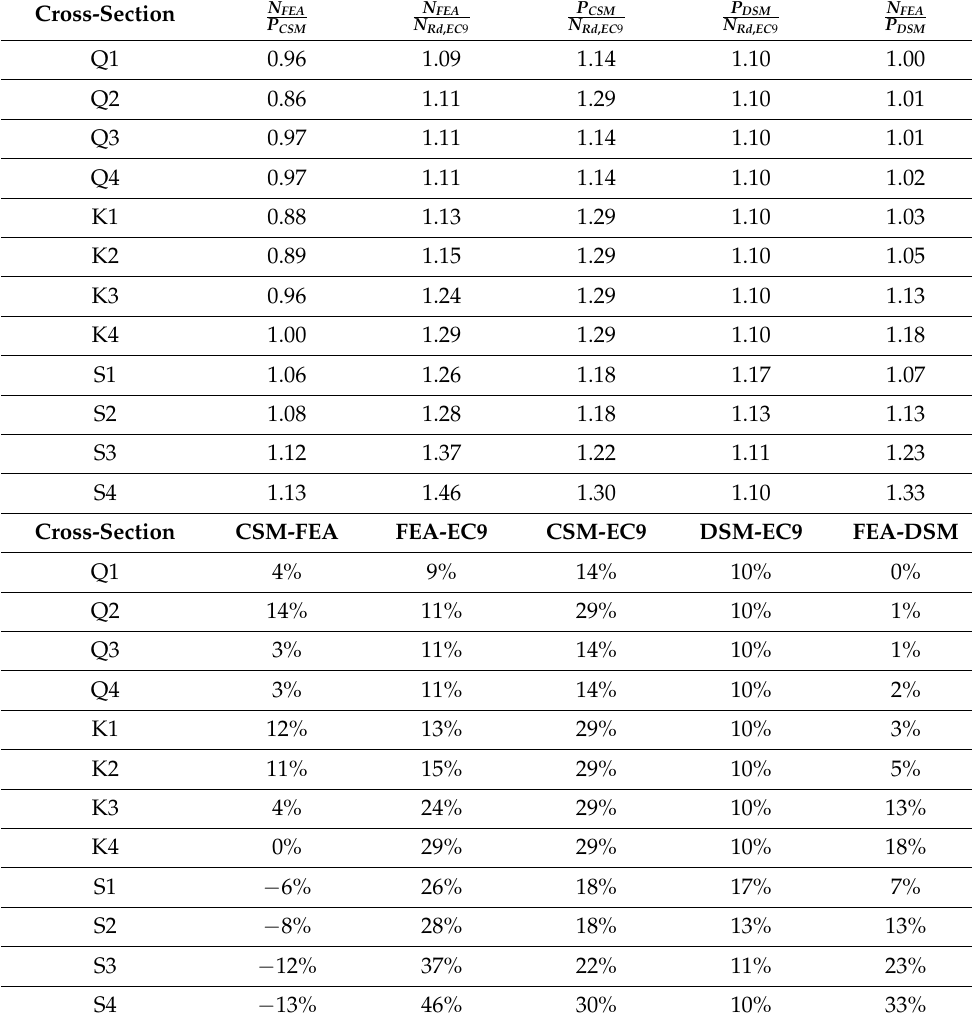
Table A1. Stocky cross-sections: comparison between the maximum compressive resistance values: ultimate load ratio and percentage deviation between two